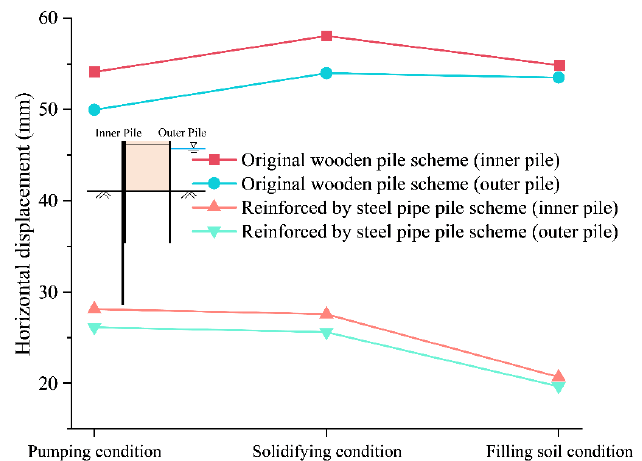
Figure 26. Comparison of the horizontal displacement between reinforced piles and double-row wood piles.